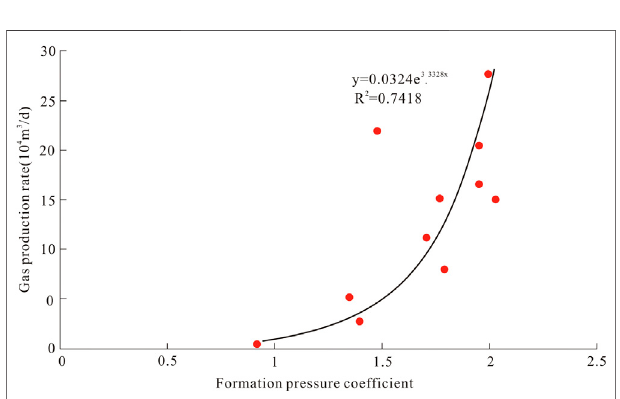
FIGURE 13 | Relationship between the formation pressure coef fi cient and shale gas production in southern Sichuan.